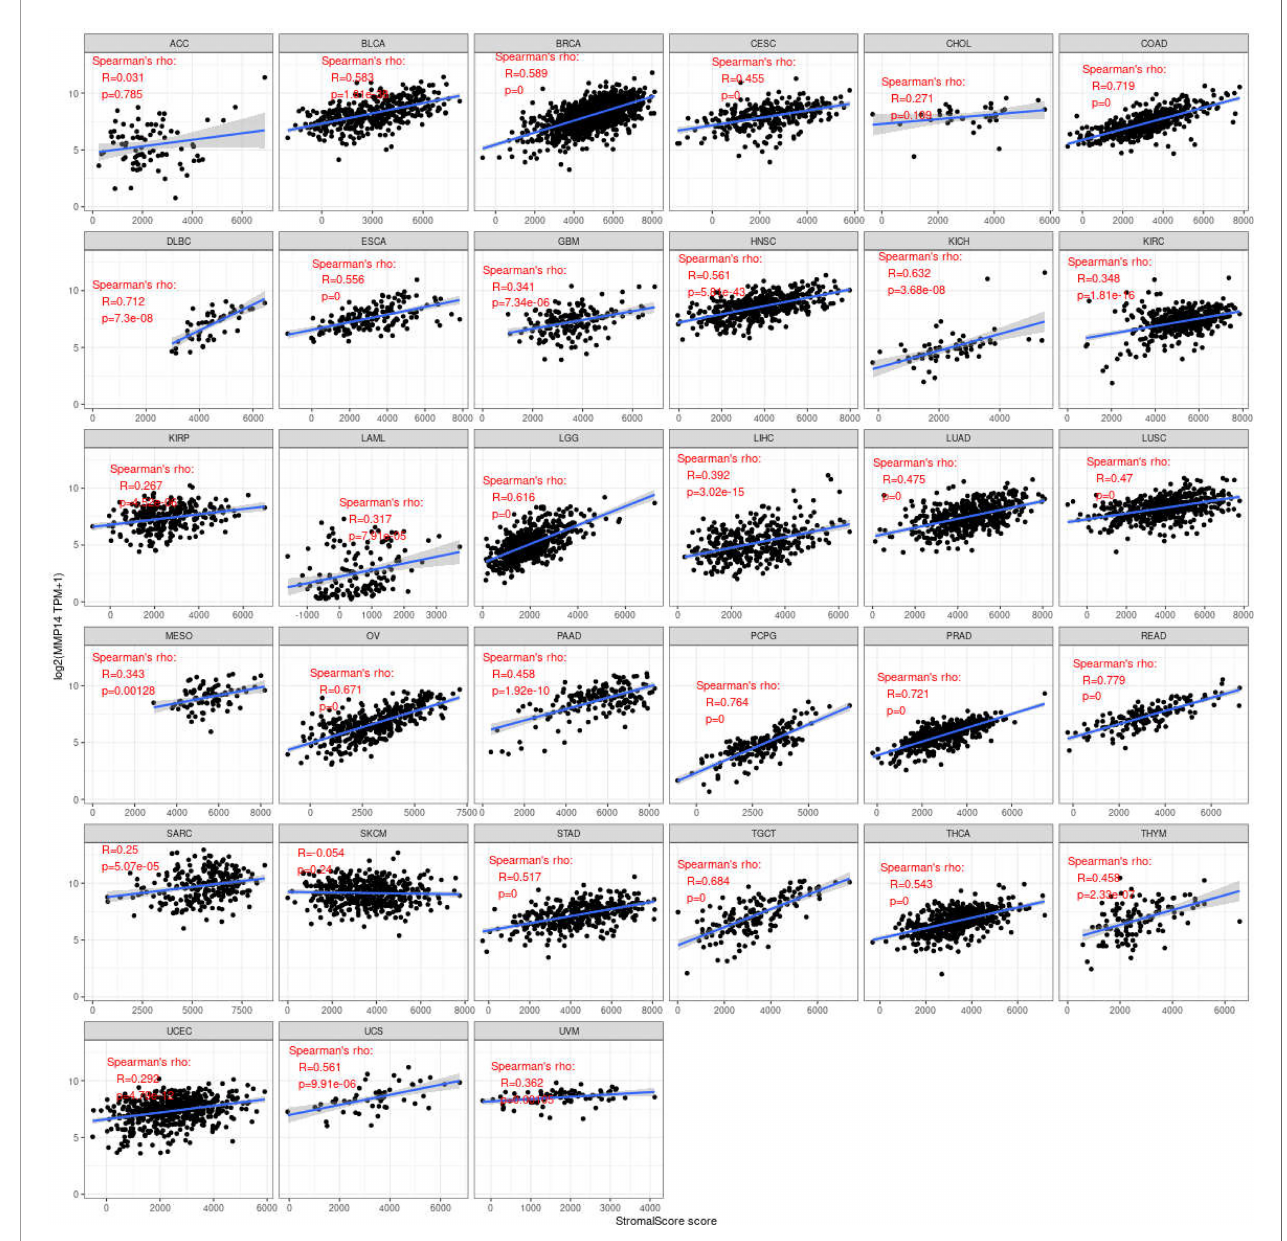
FIGURE 8 | Relationship between the expression of matrix metalloproteinase 14 (MMP14) and stromal score in pan-cancer. Only in skin cutaneous melanoma (SKCM) was the expression of MMP14 negatively correlated with immune cell in fi ltration, and the others were positively correlated with immune cell in fi ltration (p <